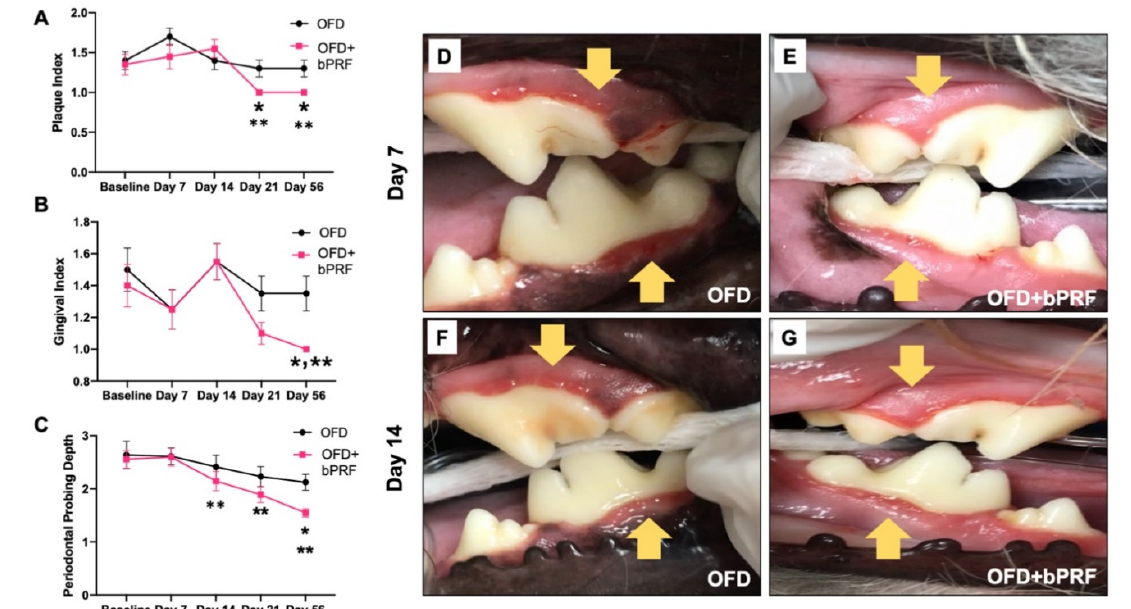
Figure 2. Bubaline blood-derived platelet-rich fibrin (bPRF) improved clinical periodontal parameters. Plaque index ( A ), gingival index ( B ), and periodontal pocket depth ( C ) were evaluated on days 0 (baseline), 7, 14, 21, and 56. Representative images of gingival status in the OFD and OFD+bPRF groups at day 7 ( D , E ) and day 14 ( F , G ) post operation. Yellow arrows indicate the surgical area. OFD; open-flap debridement-treated group, OFD+bPRF; open-flap debridement and bubaline blood-derived platelet-rich fibrin-treated group. Asterisks (*) indicate significant differences between OFD and OFD+bPRF groups at the same time point. Double asterisks (**) indicate significant differences compared with the base-line.